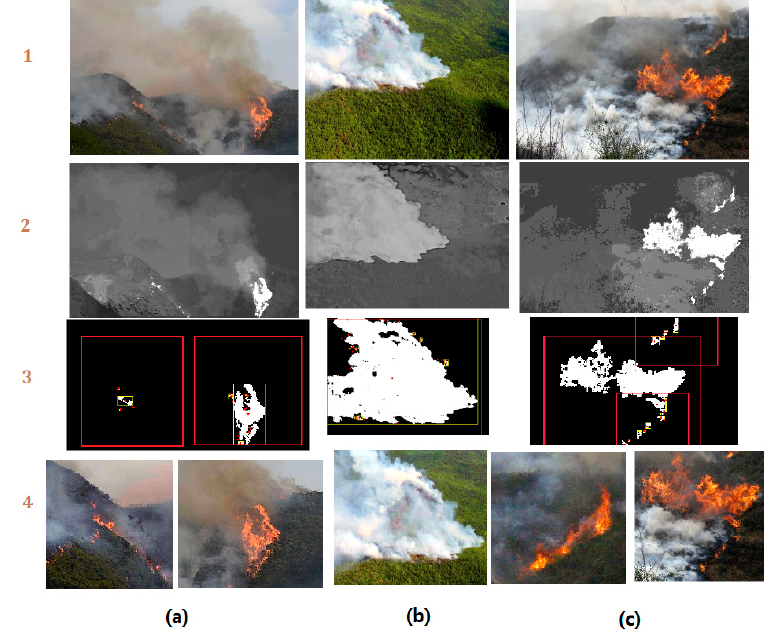
Figure 6. The saliency detection-based image segmentation: ( 1 ) Original image; ( 2 ) Saliency detection results; ( 3 ) ROI selection with logistic regression classifier and segmentation; ( 4 ) Segmented standard sized image for Fire_Net training. ( a ) Image with both flame and smoke features; ( b ) Image with only smoke feature; ( c ) Image with multiple fire regions.